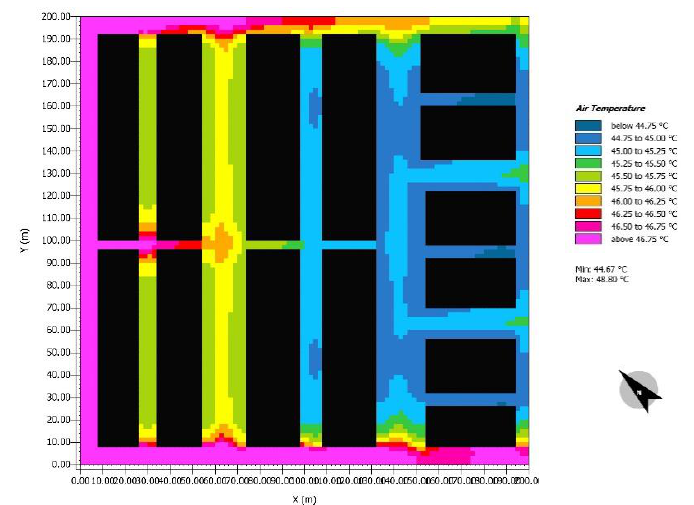
Figure 19. Air temperature for Al Safa I urban form at 2:00 pm on August 15 (ENVI-met).